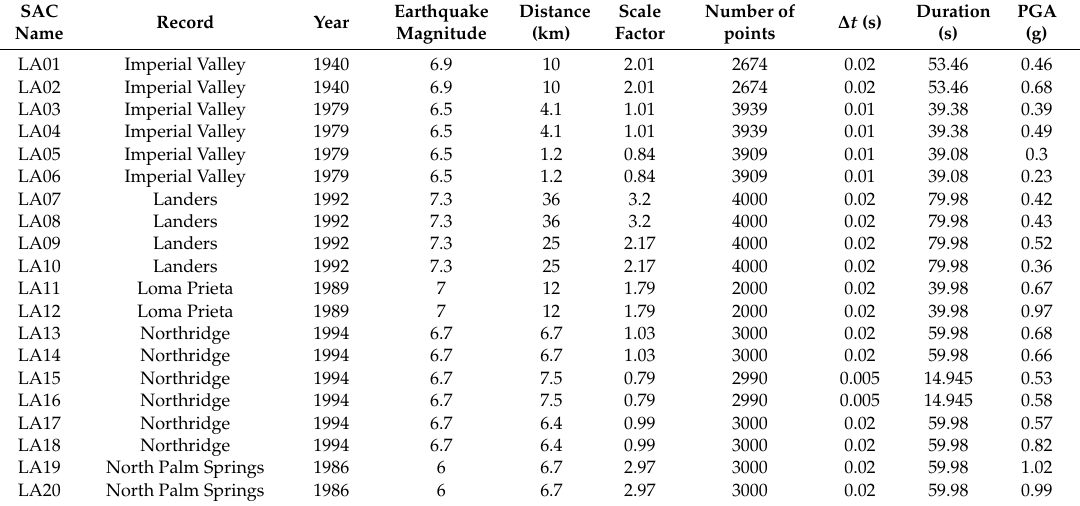
Table 1. List of the design-based earthquakes (DBE)-level earthquake ground motions used in the study and the event details.